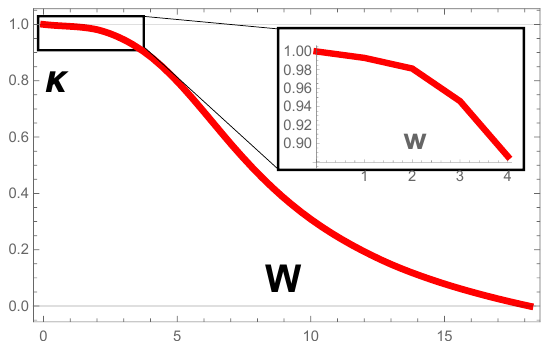
for RRG with K = 2 and box distribution of on-site